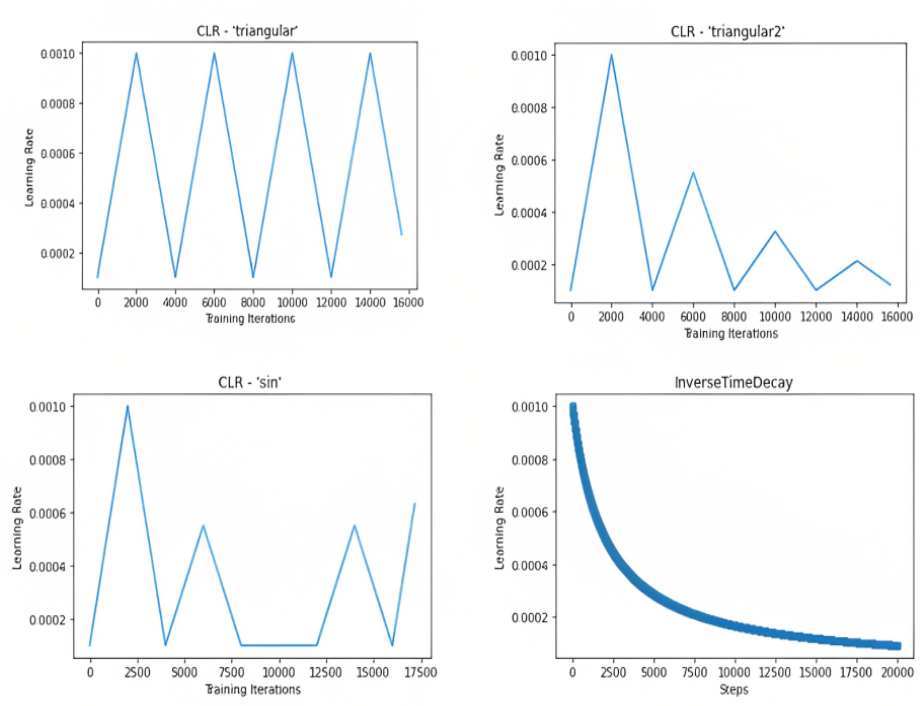
Figure 9. Different learning rate strategies versus training iterations. In the upper left corner, the Triangular LR strategy is depicted, and in the upper right corner, the Triangular 2 adaptation. In the lower-left corner, the LR strategy with the sinusoidal function and in the lower right corner is the Inverse Time Decay